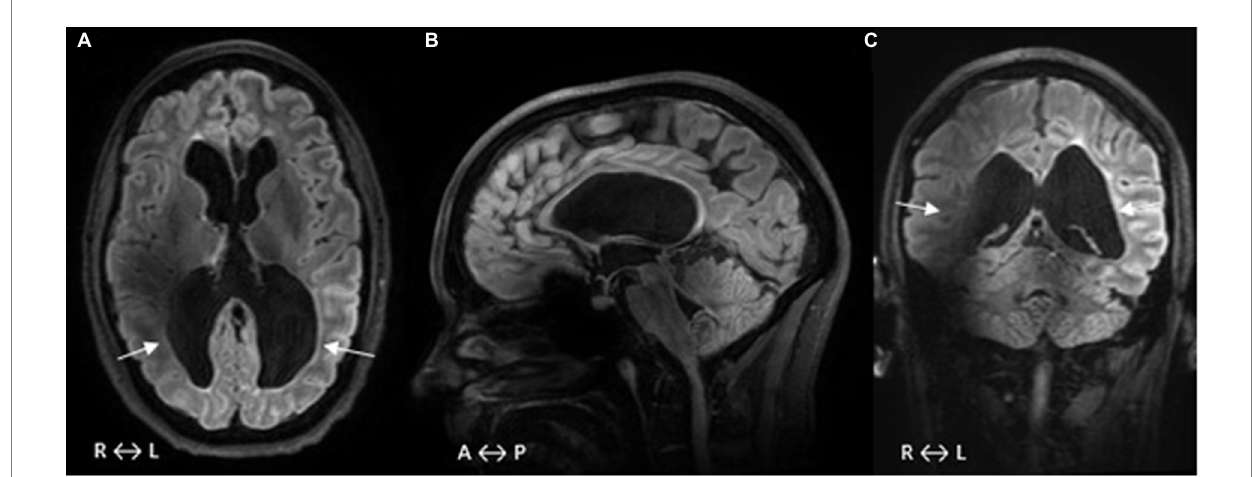
FIGURE 2 (A–C) FLAIR-MRI acquired at 7 T. A–C show a general loss of WM with secondary ventricular dilatation (A) , small areas of gliosis in the periventricular WM, and size reduction of thalami (A) . The WM volume loss is most pronounced in the parietal regions with the expected affection of each of the ORs (arrows